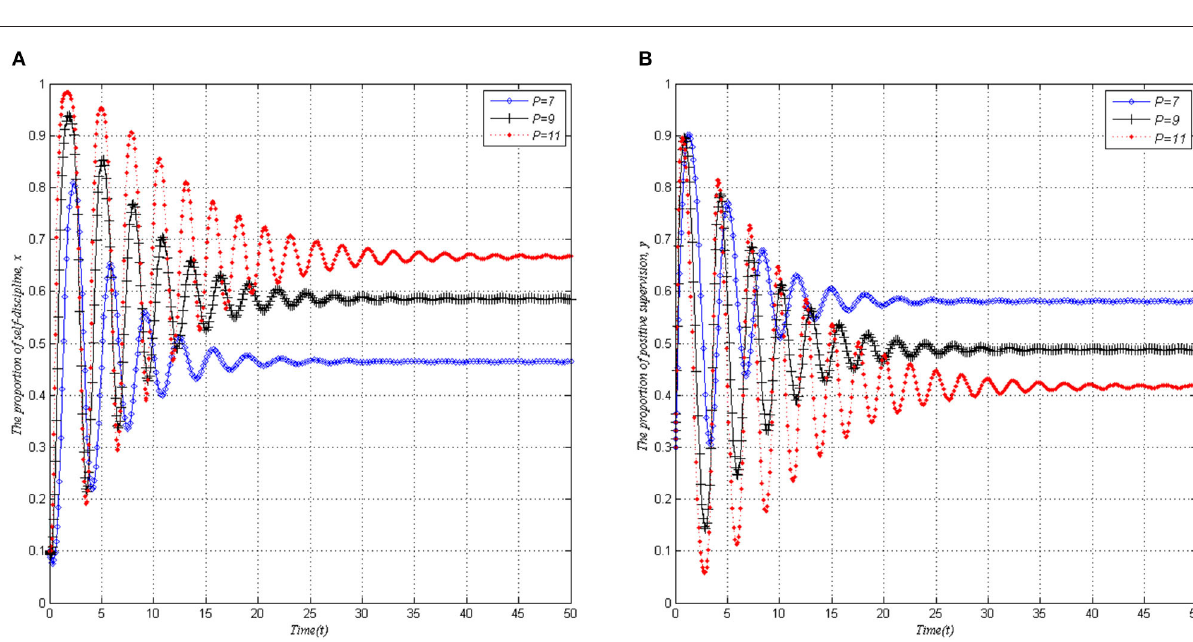
3, I 3, C 1, 1 L 4). (A) PHSIs. (B) Local = = = =